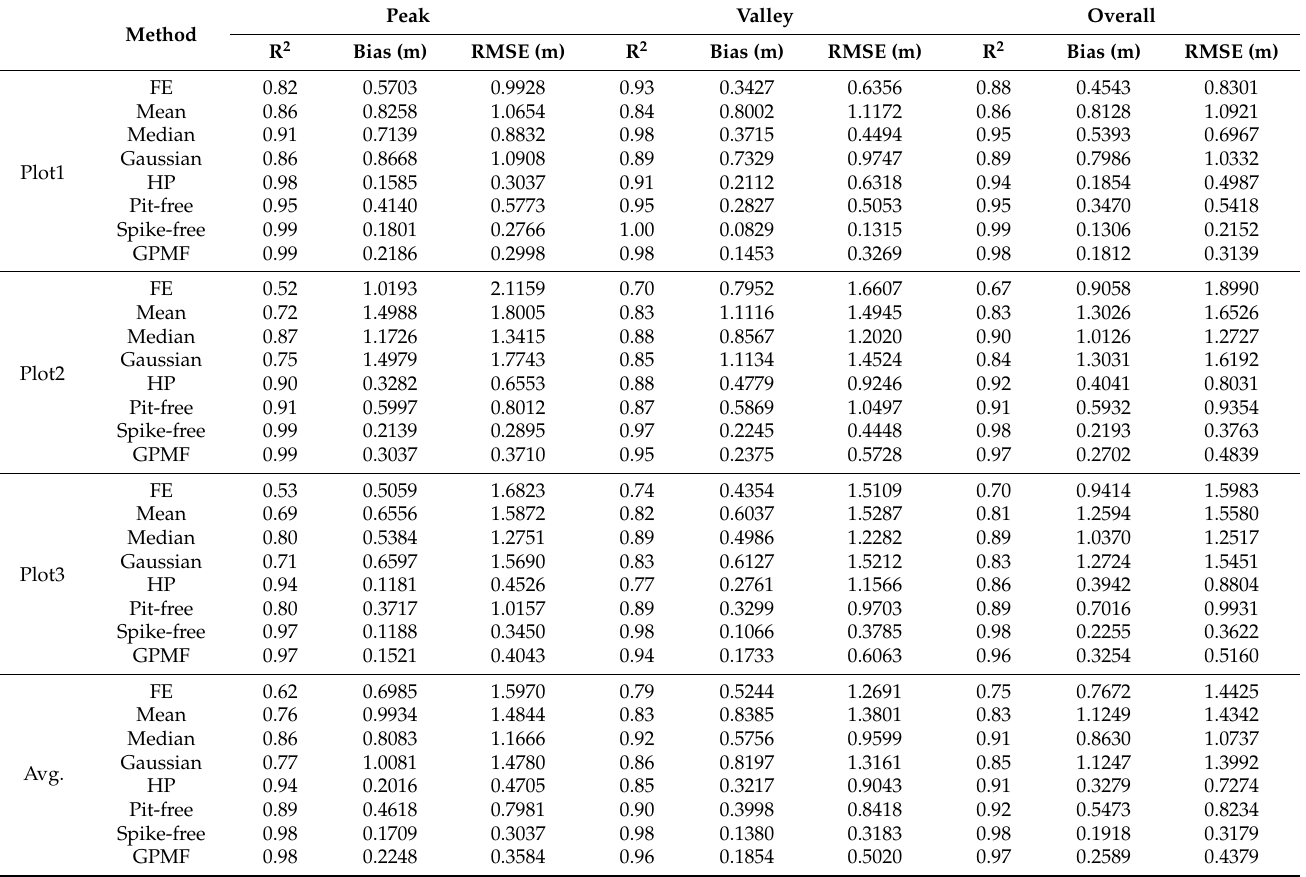
Table 3. Verification results of different CHMs and reference canopy surface